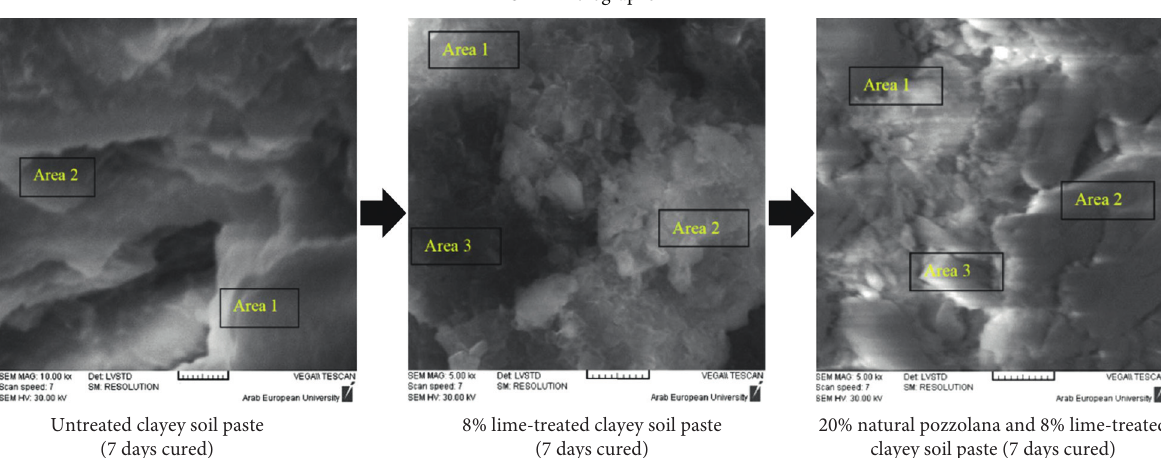
8% lime-treated clayey soil paste 20% natural pozzolana and 8% lime-treated (7 days cured) clayey soil paste (7 days